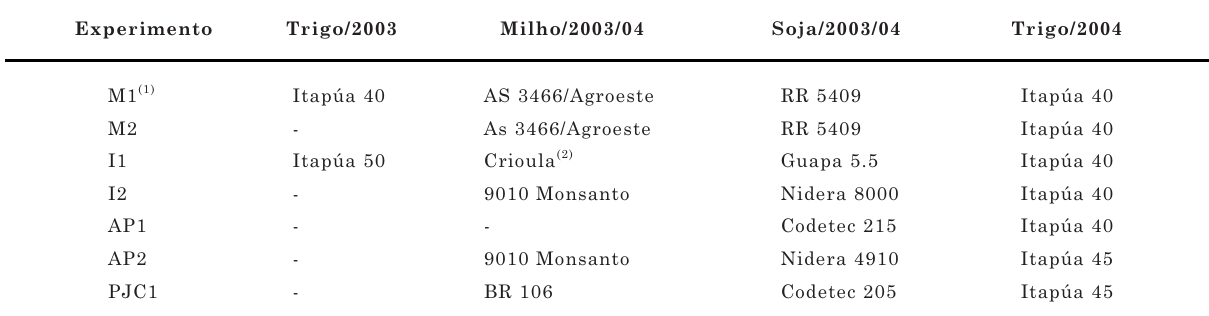
Quadro 2. Cultivares utilizadas nos anos e locais de condução do experimento. Paraguai, 2005